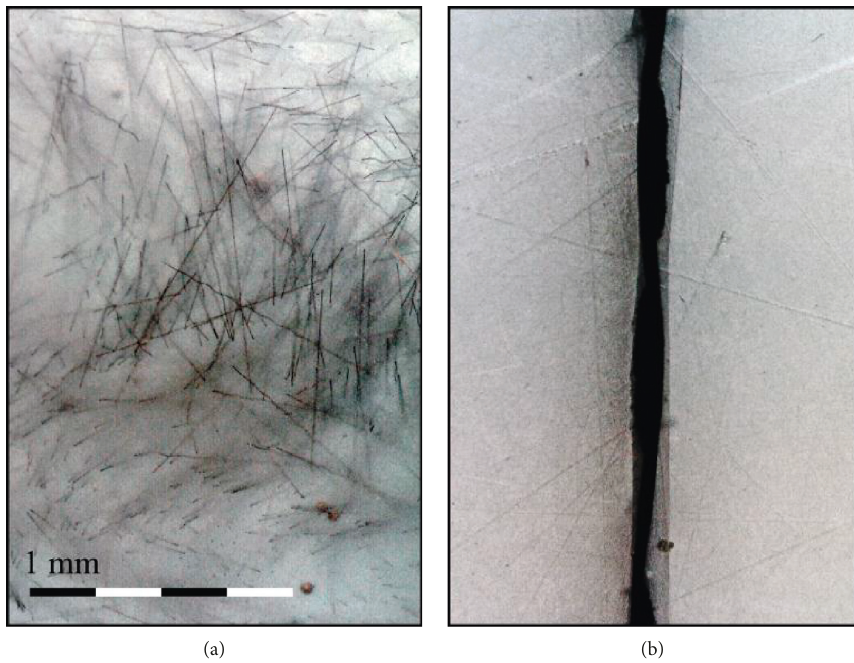
Figure 1: Polished sections of a composite materials of a series “A” (a) and a series “B”